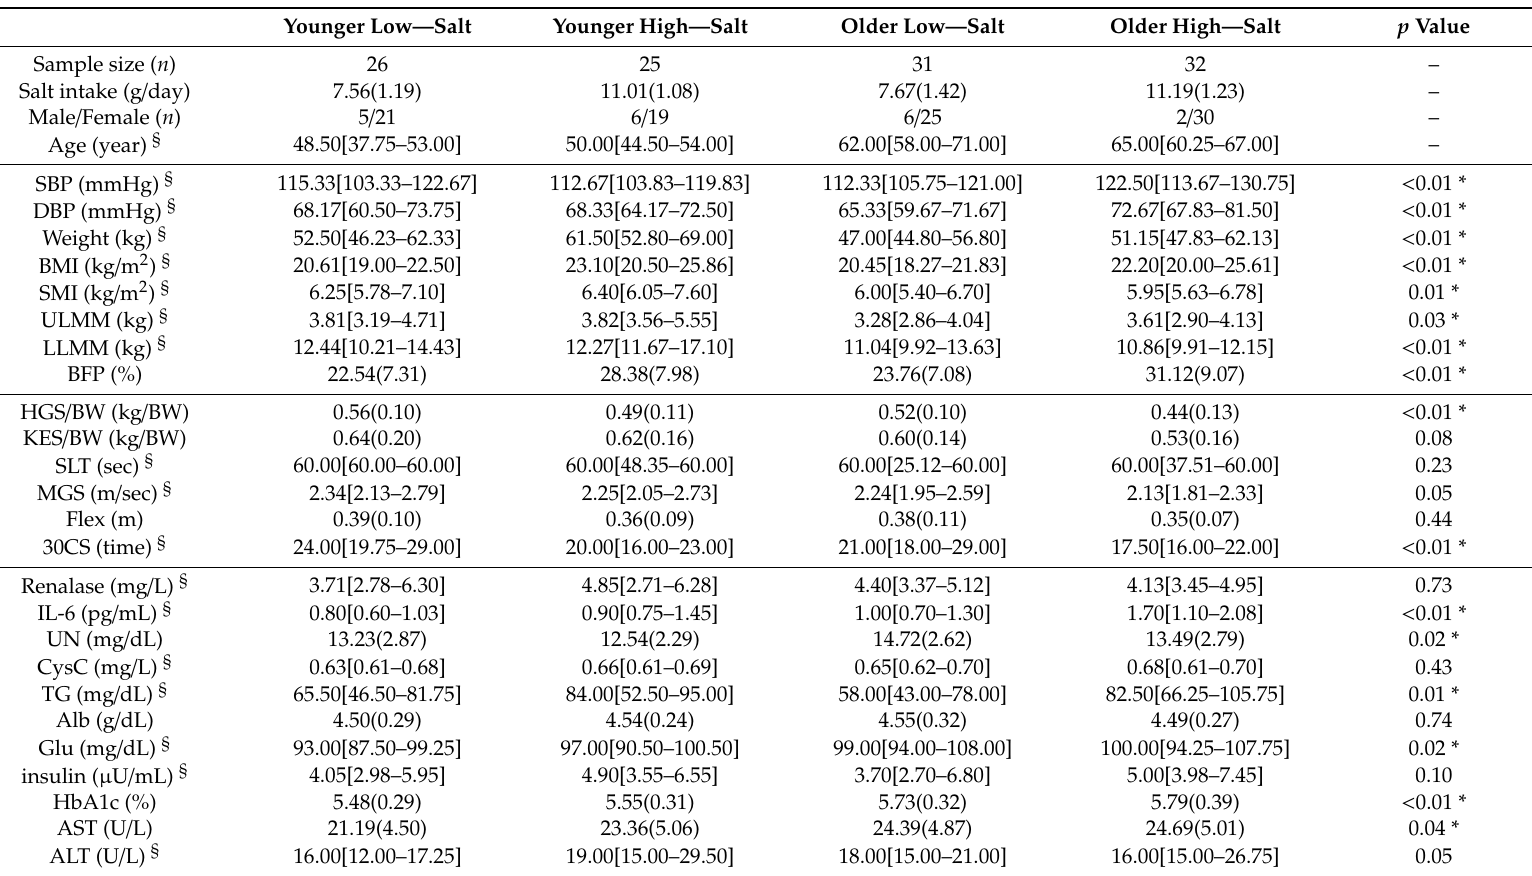
Table 3. Comparison of sarcopenia-related parameters by estimated salt intake and